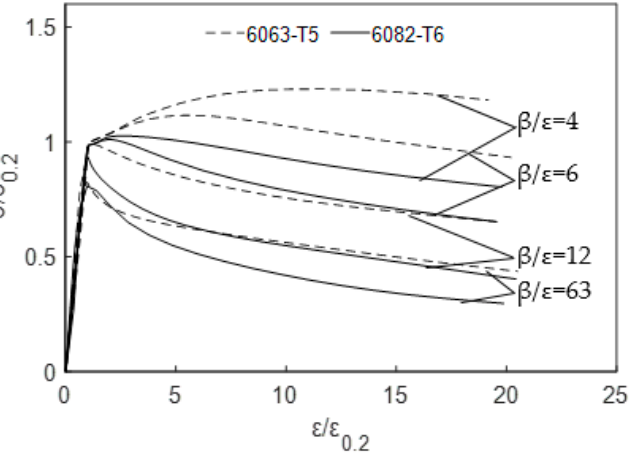
Figure 9. Typical normalised stress-strain responses for 6082-T6 and 6063-T5 cross-sections with a / b = 1.5 and different slenderness β / ε .